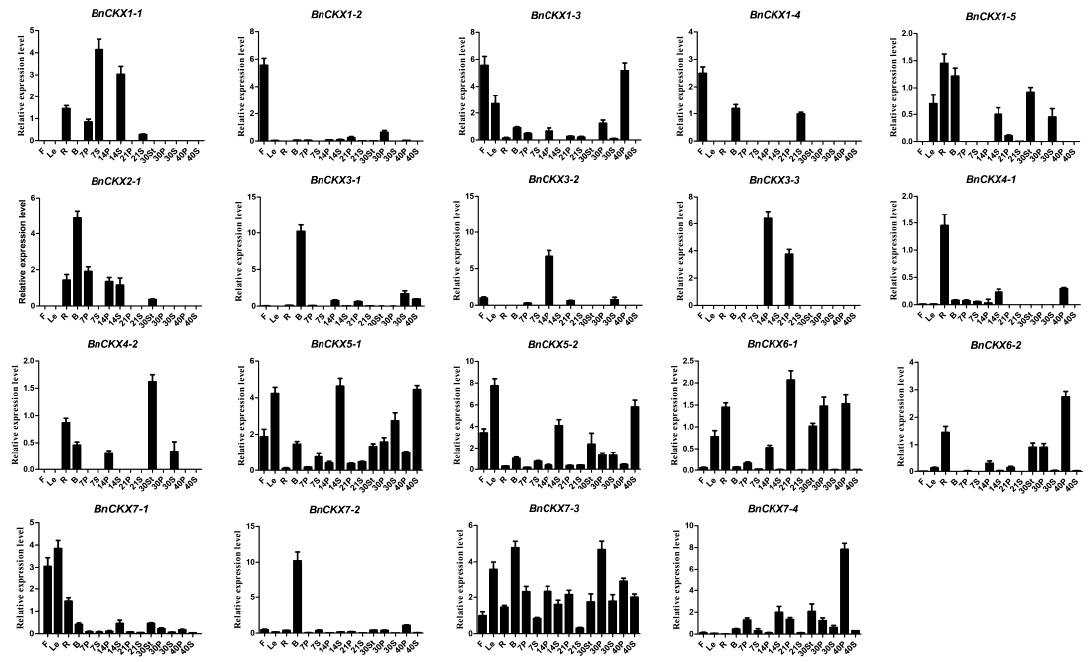
Figure 6. Expression of 19 BnCKX genes in different tissues and at different developmental stages. No BnCKX1-6, 2-2, 2-3 and 3-4 expression was detected using quantitative reverse-transcription polymerase chain reaction qRT-PCR. The expression patterns of the 23 BnCKX genes in B. napus cultivar Zhong Shuang 11 (‘ZS11’) were analyzed by qRT-PCR. F: flowers; Le: leaves; R: roots; B: buds; 30St: stems on day 30; 7S, 14S, 21S, 30S, 40S: seeds collected at 7, 14, 21, 30 and 40 days after flowering, respectively. 7P, 14P, 21P, 30P, 40P: silique pericarps collected at 7, 14, 21, 30, and 40 days after flowering, respectively.